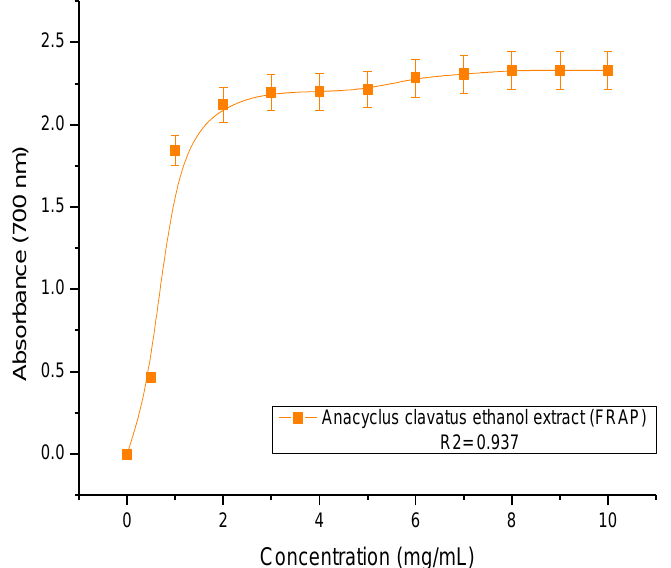
Figure 2. Antioxidant capacity of the ethanolic extract of Anacyclus clavatus flowers assessed using a PFRAP assay.